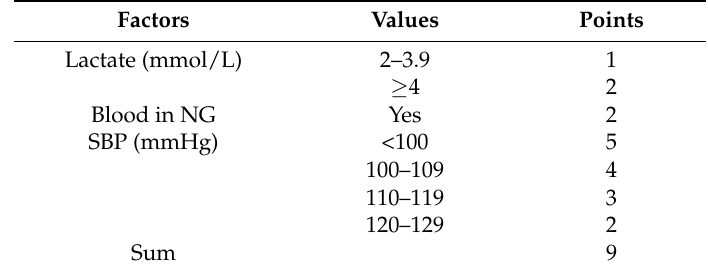
Table 2. New prognostic models for predicting the occurrence of hypotension in non-variceal upper gastrointestinal bleeding (LBS).